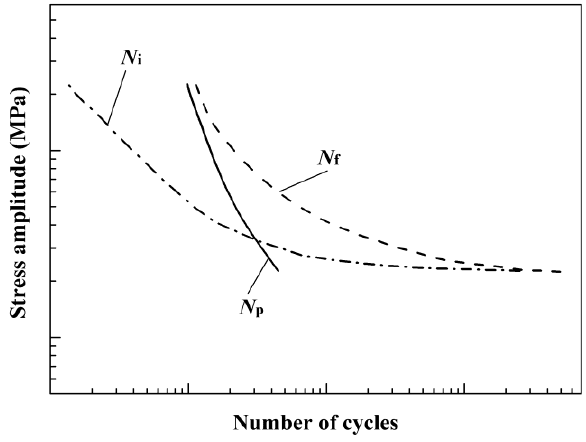
Figure 12. Number of cycles for fatigue crack initiation, fatigue crack propagation and total fatigue life as a function of the applied stress